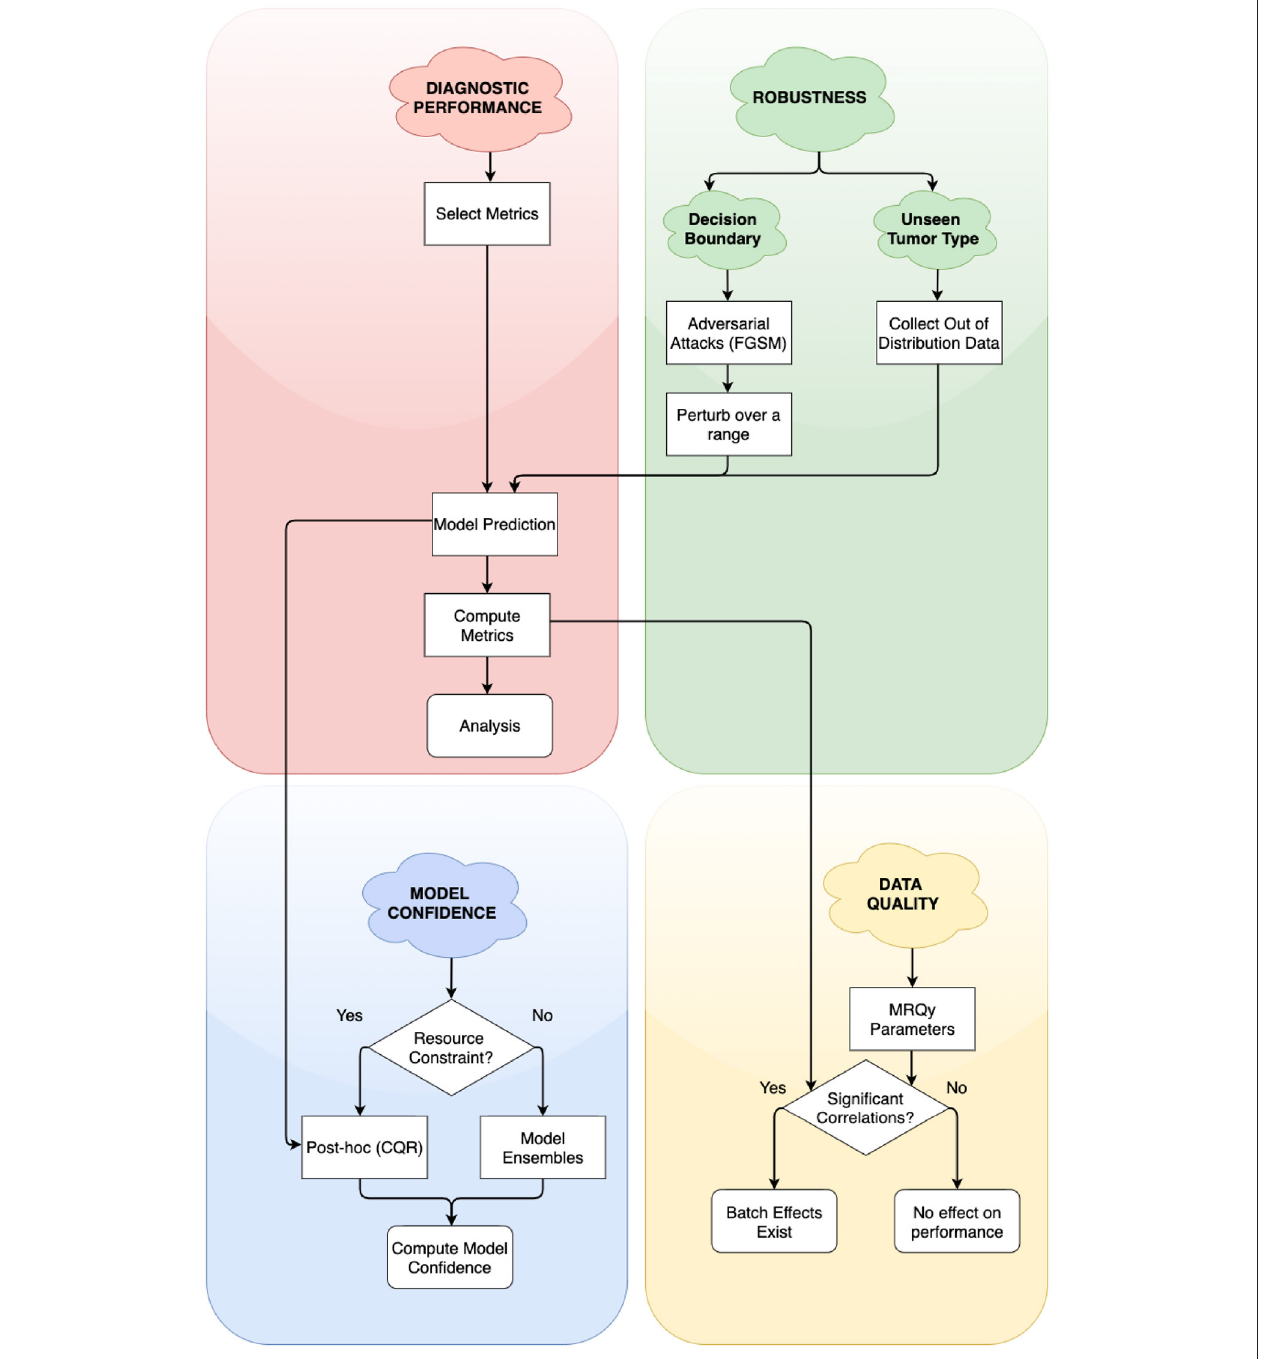
FIGURE 1 | Simplified flowchart of different axes of holistic evaluation—diagnostic performance, robustness, model confidence, and data quality. Axes are ordered by dependency and relation with each other. We recommend models to be evaluated with atleast one experiment on each of these axes. We evaluate two aspects of robustness, namely, closeness to decision boundary and generalizability on unseen glioma type. Decision points in the framework lead to alternate paths for researchers to follow.